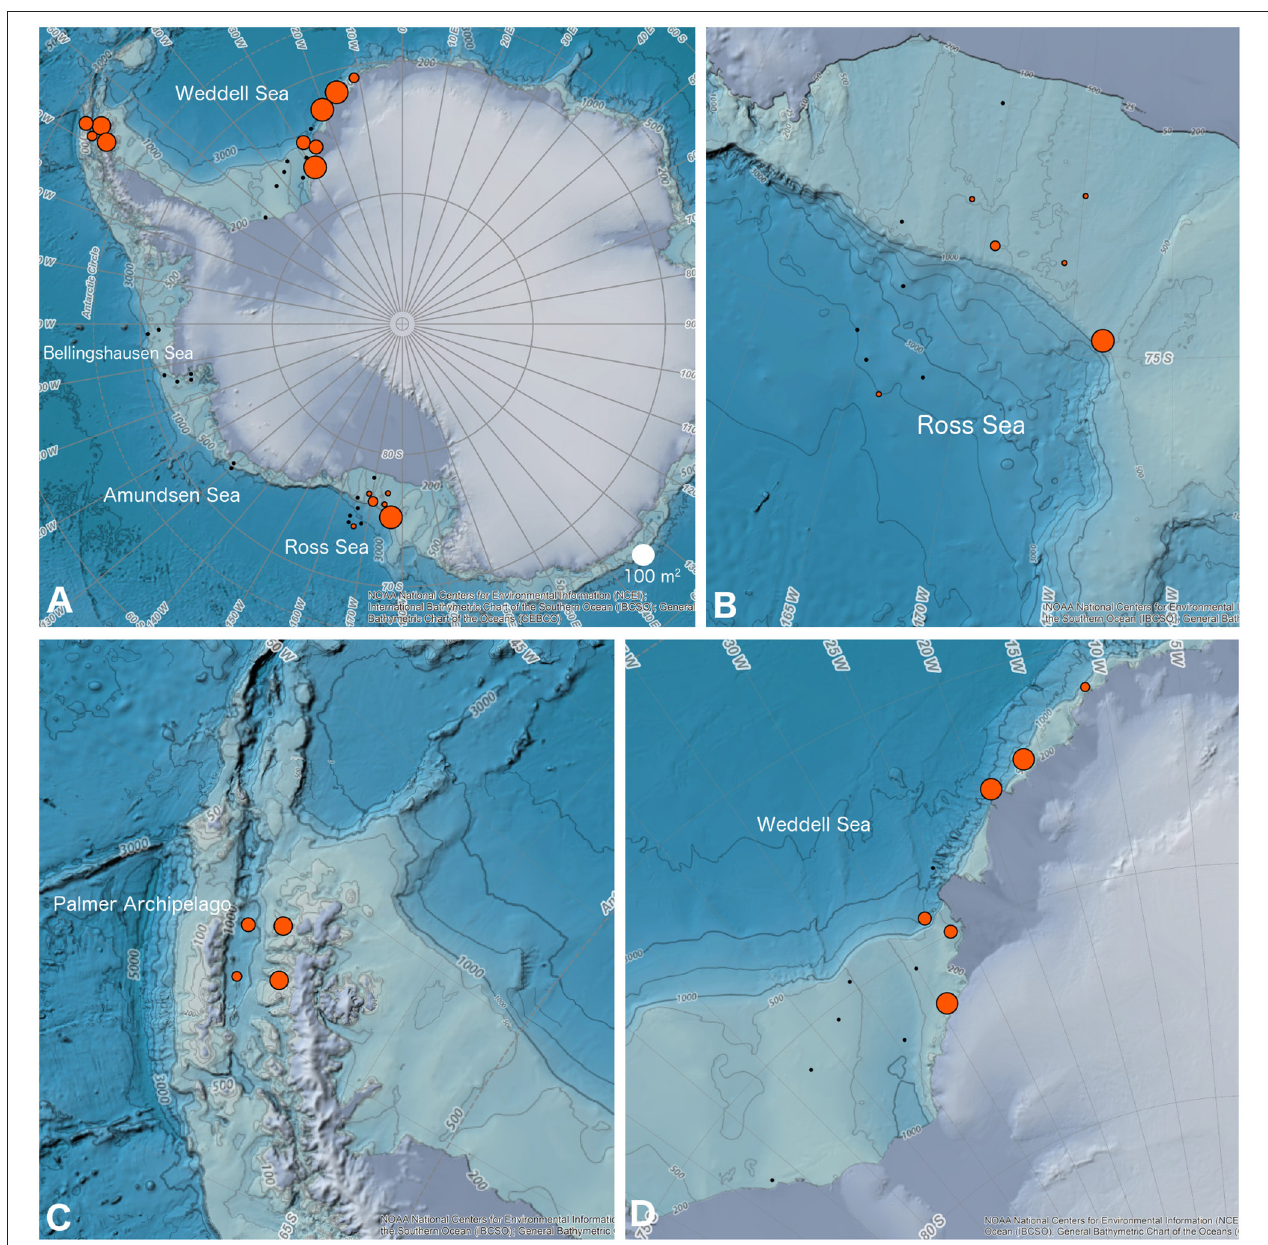
FIGURE 3 | GIS maps of the location and area of bryozoan-rich and habitat-forming bryozoan communities considered in this paper. (A) Map of Antarctica showing all sites. (B) Ross Sea. (C) Sites along the northern portion of the Palmer Archipelago where it borders the Scotia Sea. (D) Weddell Sea. Black dots are areas included in the imaging surveys, but where habitat-forming bryozoan communities were not observed. Red circles are areas with habitat-forming bryozoan communities scaled by the total bryozoan area. The NOAA GIS base maps of Antarctica obtained from a web-shared